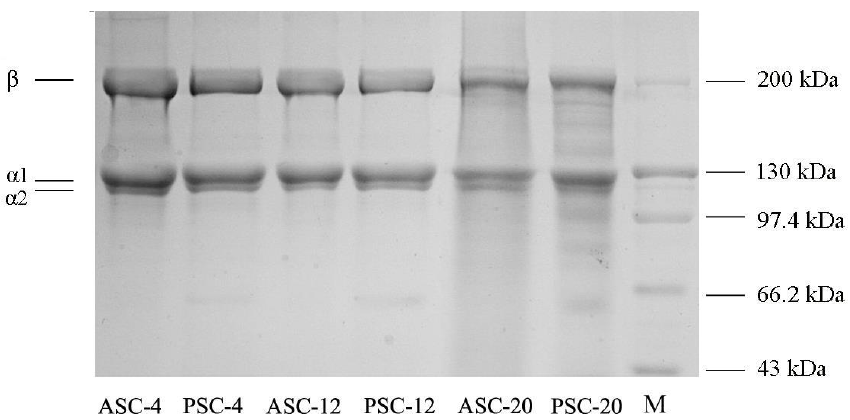
Figure 2. SDS-PAGE patterns of ASC and PSC extracted at 4, 12, and 20 °C from the skin of puffer- fish. ASC: acid-solubilized collagen; PSC: pepsin-solubilized collagen; M: protein marker.